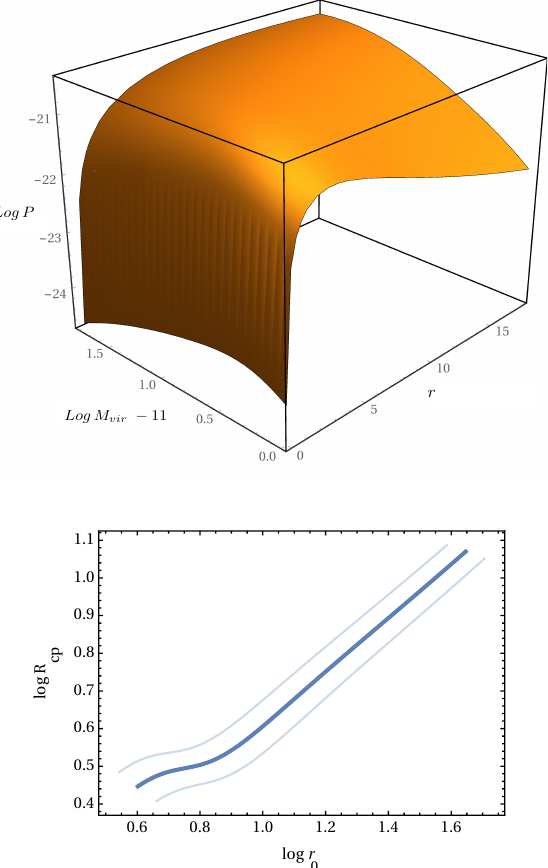
Figure 2. Up. The Dark Matter (DM) pressure in Spirals (cgs units) as function of halo mass (in solar masses) and radius (in kpc). Bottom. Log R cp / kpc vs. Log r 0